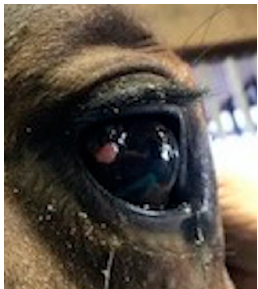
Figure 1. Clinical photograph of right eye of a Holsteiner–Belgian Warmblood cross (Case 1) showing a mass on the temporal bulbar conjunctiva.